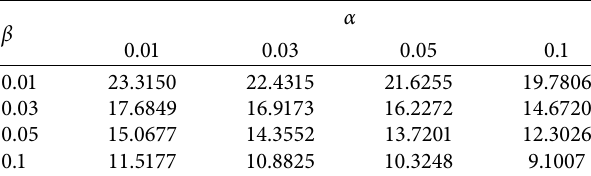
τ ∗ approximation. σ 1